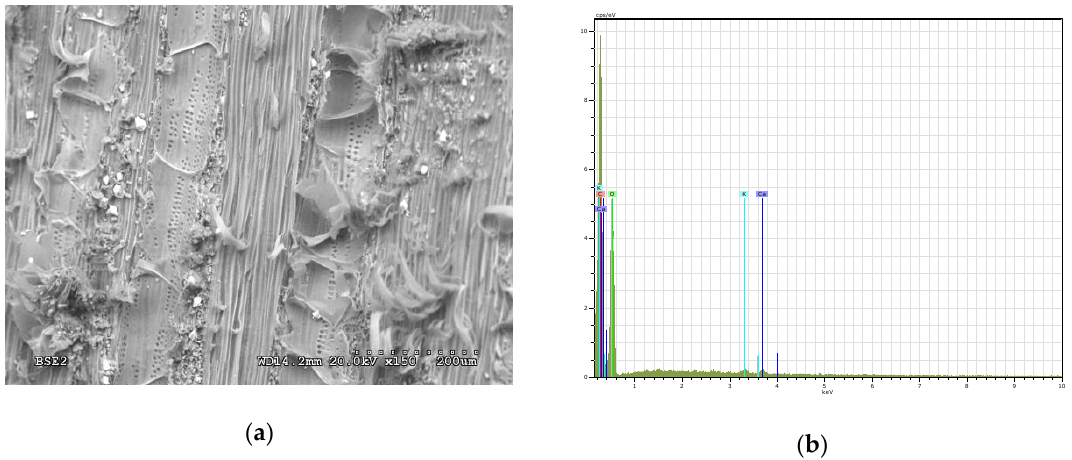
Figure 3. ( a ) Scanning electron microscope (SEM) image, ( b ) energy-dispersive X-ray spectroscopy (EDS) analysis.